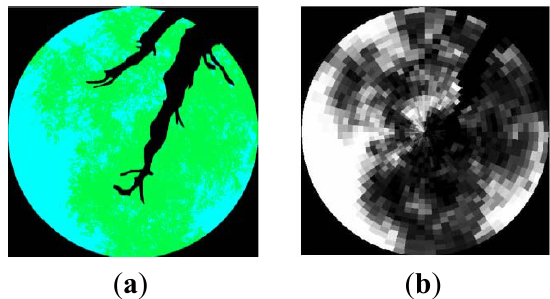
Figure 9. Hemispherical view of a single tree, ( a ) segmented image, ( b ) gap fraction P